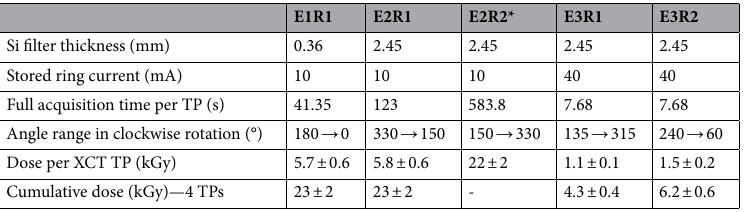
Table 3. Modeling results showing incremental and cumulative absorbed doses by each root imaged at MOGNO-A. *This result was not considered for root growth analysis because exact growth rate measurements could not be made. † The 4 TPs considered for the cumulative dose are those from Fig. 4a.